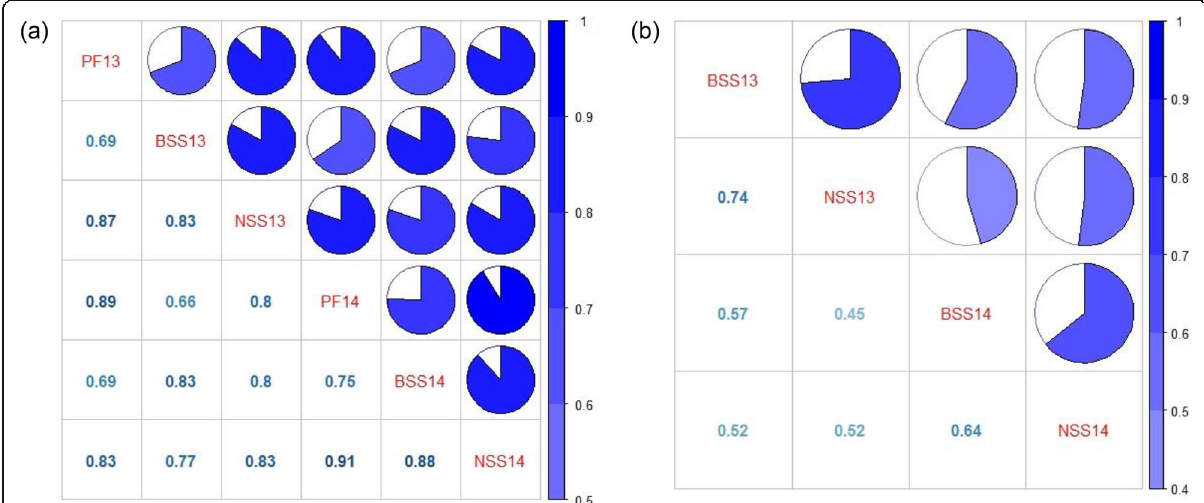
Fig. 3 Correlation coefficients among fertility-related traits in the F 1 population with the background of CMS-WA ( a ) and the F 1 population with the background of CMS-HL ( b ) in year 2013 and 2014. In a and b , positive significant correlations were observed in all the traits at the level of p < 0.001. PF13, BSS13 and NSS13 represent the pollen fertility, BSS and NSS in year 2013 respectively. Similarly, PF14, BSS14 and NSS14 represent the three traits in year 2014 respectively